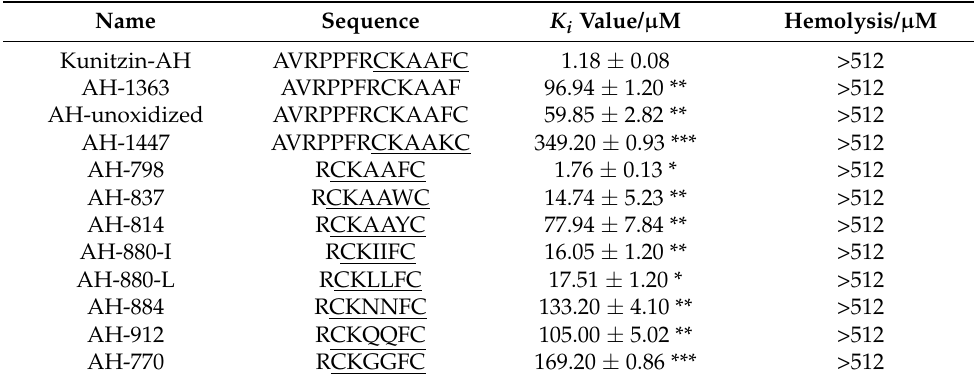
Table 1. A summary of K i 1 values of Kunitzin-AH and its